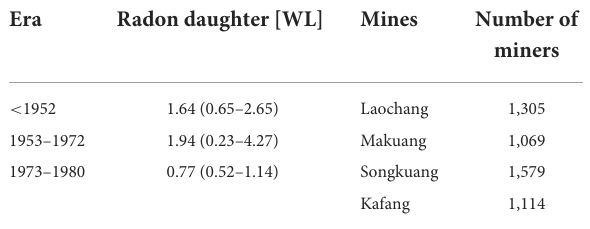
TABLE 2 Calculated or measured mean values of Radon Concentration by